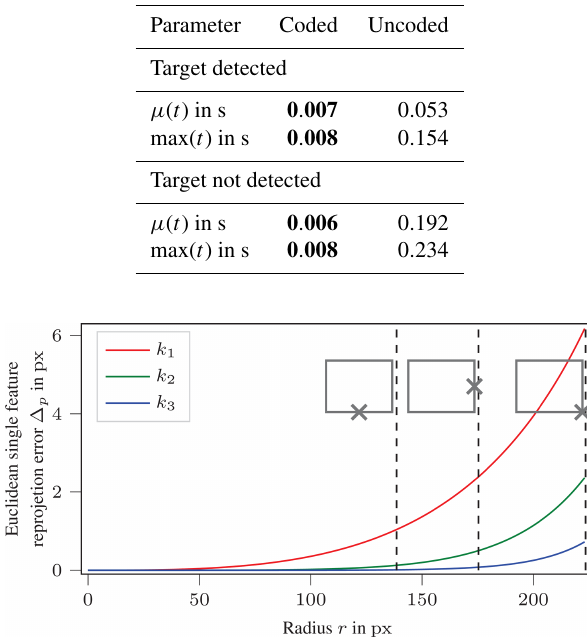
is shown in bold.